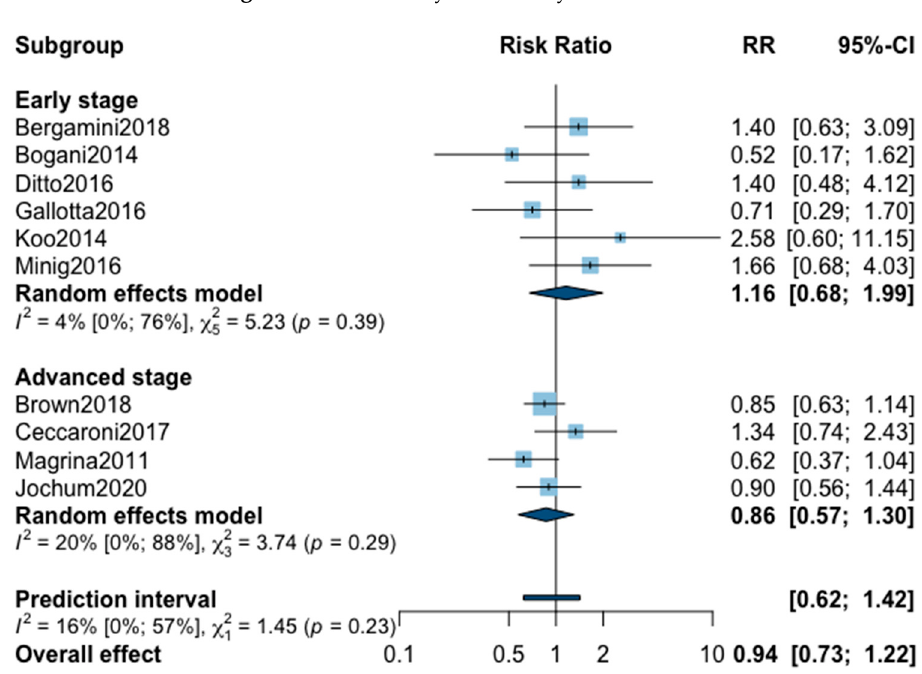
Figure A2. Meta-analysis for three-year Figure A2. Meta ‐ analysis for three ‐ year recurrence . Figure A2. Meta ‐ analysis for three ‐ year recurrence .